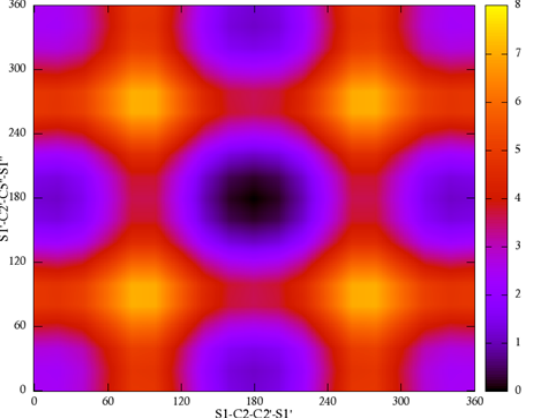
Figure 3. Energy surfaces as function of dihedral angles in 2,2 ′ :5 ′ ,2 ″ -terthiophene. On these bases, the singlet excited states were calculated (Table 2) evidencing that all λ max values are in a narrow range (360–390 nm), being ascribable to π - π * transitions on the common terthiophene skeleton of the investigated species. Experimental and theoretical λ max values are in good agreement, as well as Eg,opt values, showing a 15% maximum difference between the calculated and experimental data. The red-shift in λ max and the corresponding lowering in Eg,opt argue a more extended conjugation in the terthiophene framework, due to the presence of an unsaturated fragment on the C-5 atom instead of on the C-3 (cid:48)